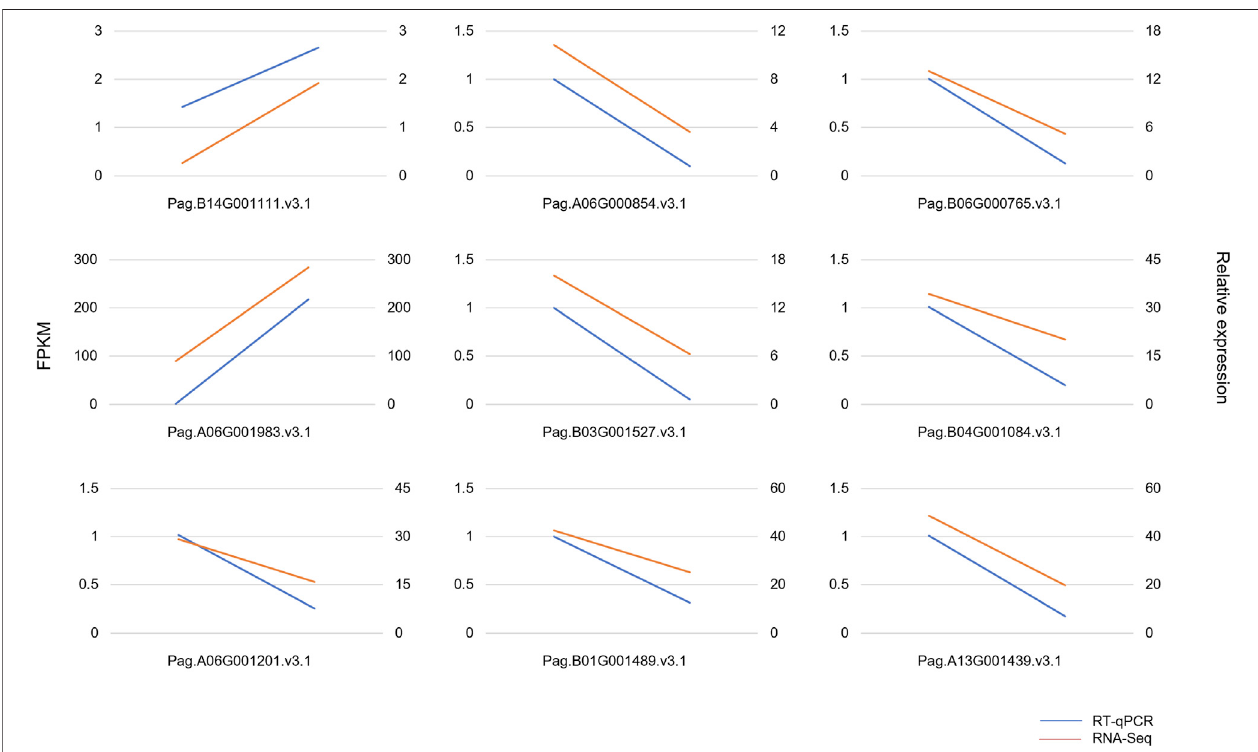
FIGURE 2 | Quantitative real-time PCR veri fi cation of RNA-Seq. The red lines represent the results of RT-qPCR, and the blue lines represent the results of RNA- Seq.The y -axisontheleftrepresentstheFPKMvalueobtainedbyRNA-Seq.The y -axisontherightshowsthegenerelativeexpressionlevelsanalyzedbyRT-qPCR.The endpoints on the left represent gene expression in WT, and endpoints on the right represent gene expression in